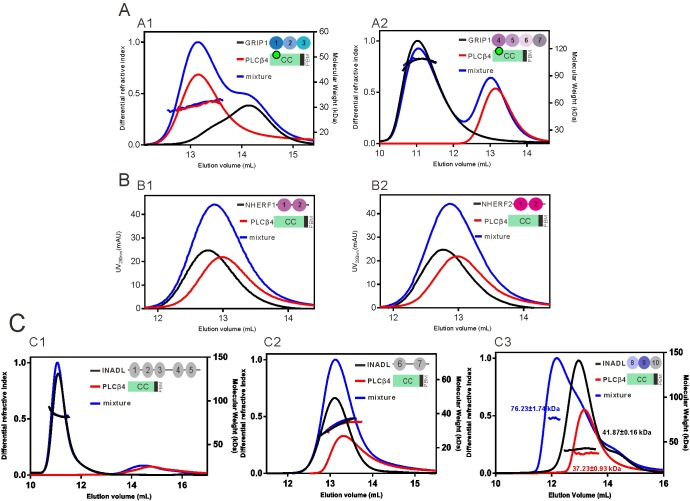
The PLCβ4 CC-PBM specifically interacts with INADL.(A) The PLCβ4 CC8KA-PBM has no detectable interaction with GRIP1 PDZ1-3 (A1) or PDZ4-7 (A2). Analytical gel filtration chromatography analysis coupled with static light scattering analysis showing that mixing of PLCβ4 CC8KA-PBM with GRIP1 PDZ domains showed no obvious elution volume changes for either PLCβ4 CC8KA-PBM or GRIP1 PDZ domains. (B) Analytical gel filtration chromatography analysis showing that PLCβ4 CC-PBM WT has no detectable interaction with NHERF1 PDZ12 (B1) or with NHERF2 PDZ12 (B2). (C) PLCβ4 CC-PBM WT specifically interacts with INADL PDZ8-10. Analytical gel filtration chromatography analysis coupled with static light scattering analysis showed that the mixing of INADL PDZ8-10 with PLCβ4 CC-PBM WT induced an obvious elution volume shift of CC-PBM (C3), whereas mixing of either INADL PDZ1-5 or PDZ6-7 with CC-PBM PLCβ4 did not induce an elution peak shift (C1 and C2).